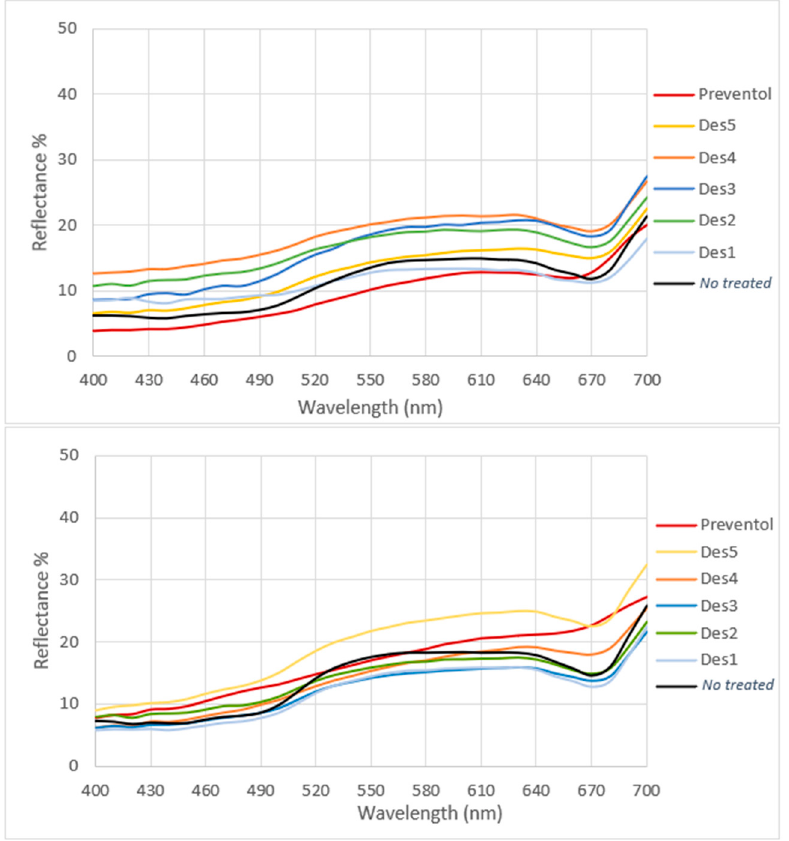
Figure 3. Full ‐ spectrum color measurement of the treated zone in Area 1 ( above ) and in Area 2 ( below ) in comparison with the no treated zone indicated in black.